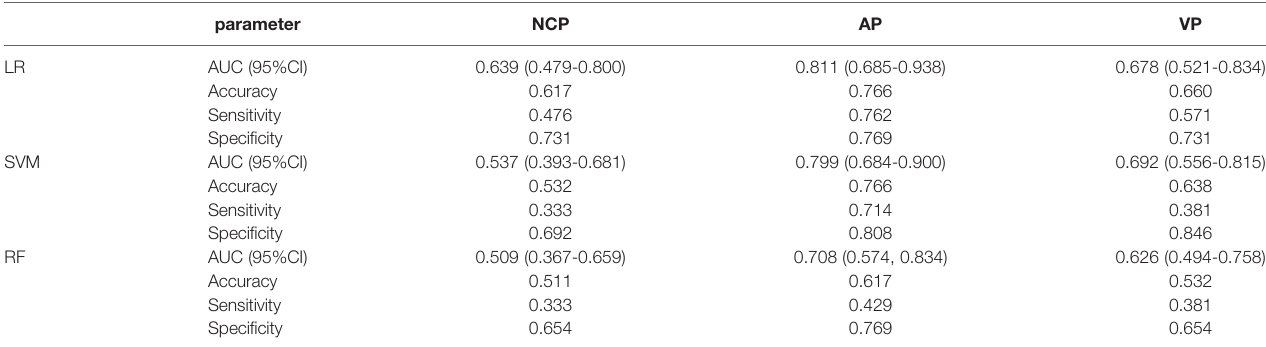
FIGURE 4 | The receiver operating characteristic curves of radiomic models based on different CT-phase images in the training (A – C) and test (D – F) cohort, respectively. N-model: NCP model; A-model: AP model; V-model: VP model; A+V-model: AP+VP model; A+V+N-model: AP+VP+NCP model; A&V-model: AP&VP model; A&V&N-model: AP&VP&NCP-model. TABLE 3 | Performance of the single-phase model in the test cohort.